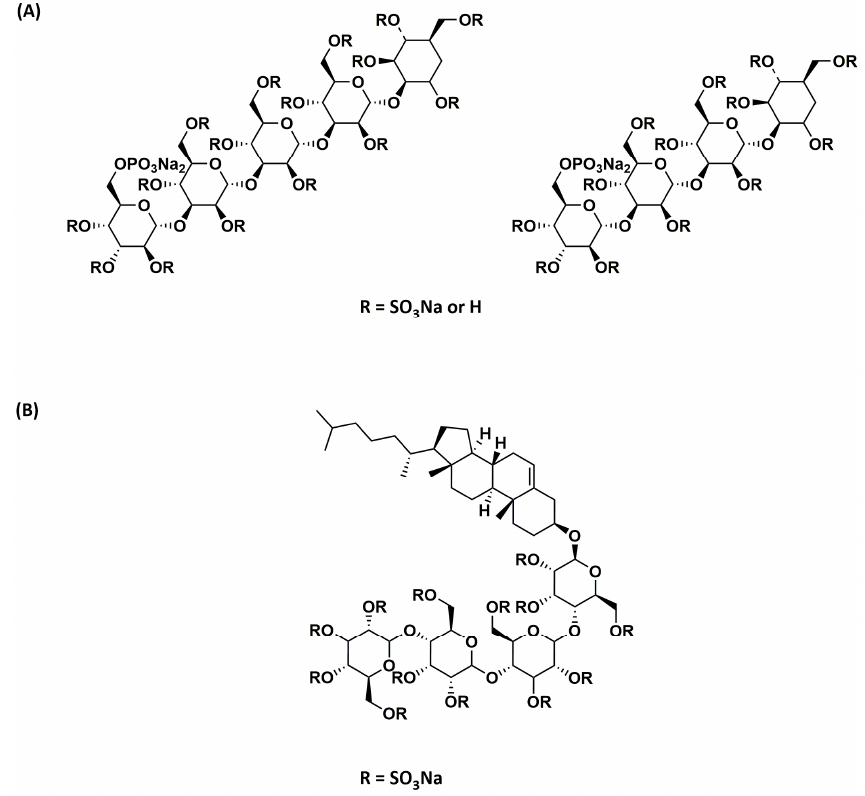
Figure 3. Chemical structure of ( A ) PI-88 and ( B ) PG545.